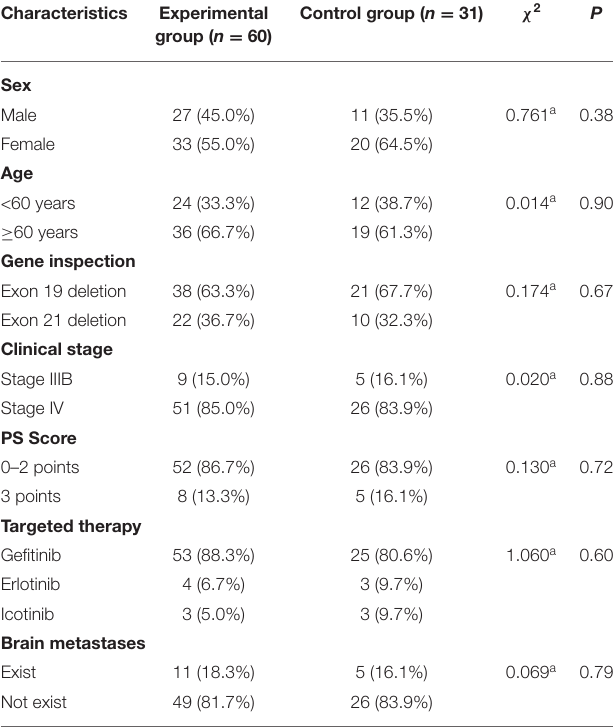
TABLE 1 | Characteristics of patients [ n